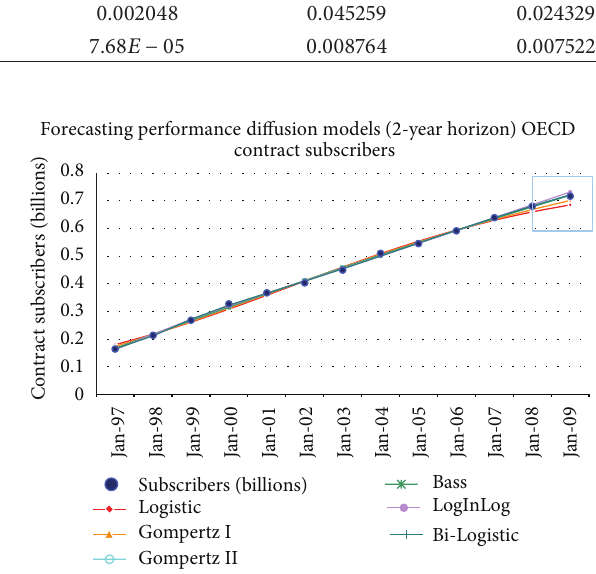
Figure 23: The forecasting performance of the diffusion models (forecast window—2 years ahead) for the number of OECD mobile contract subscribers.